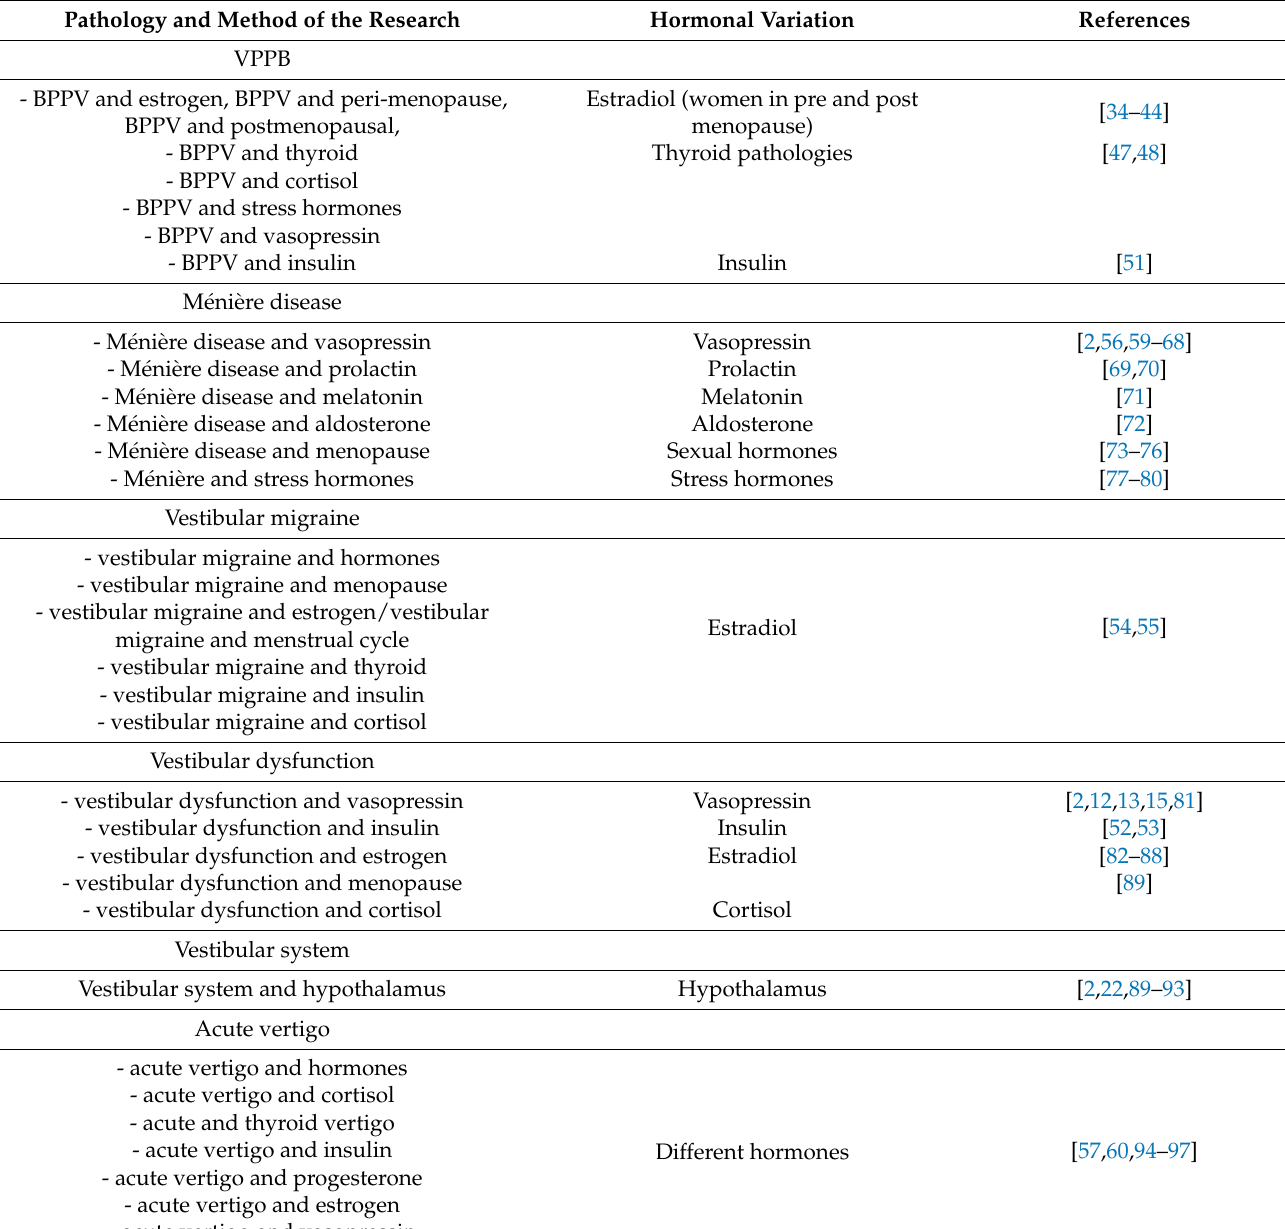
Table 1. Table displaying the research method and references of the collected studies associating hormonal variations and vestibular pathologies. Research carried out in February